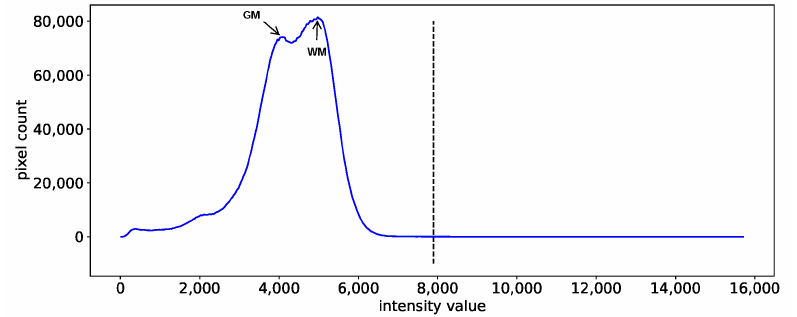
Figure 2. Example of an image histogram of the T1-weighted brain MRI image. Here GM and WM represent the gray matter and white matter of the brain,